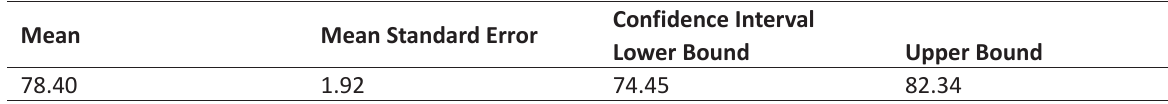
Table 6. Results of Covariance Analysis to Compare State Confidence Changes between the Study Groups Source